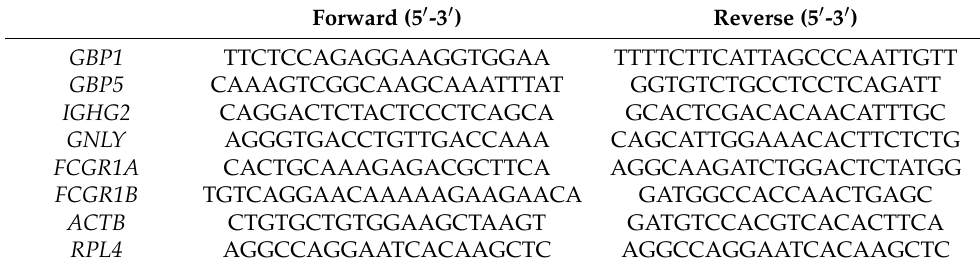
Table 1. Oligonucleotide sequences used for PCR